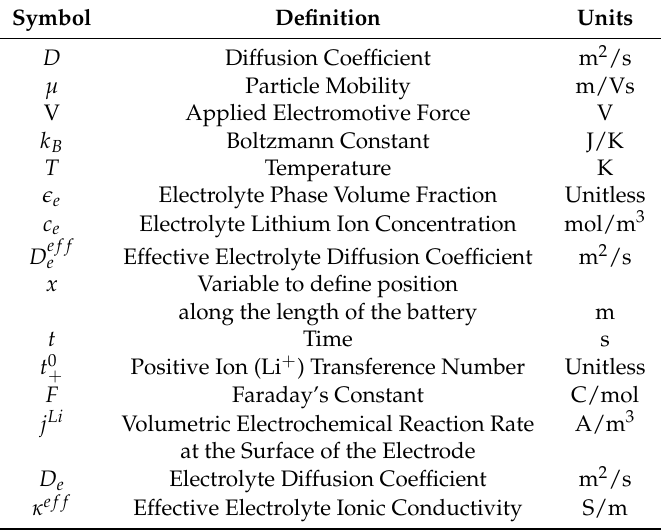
Table A1. Table of